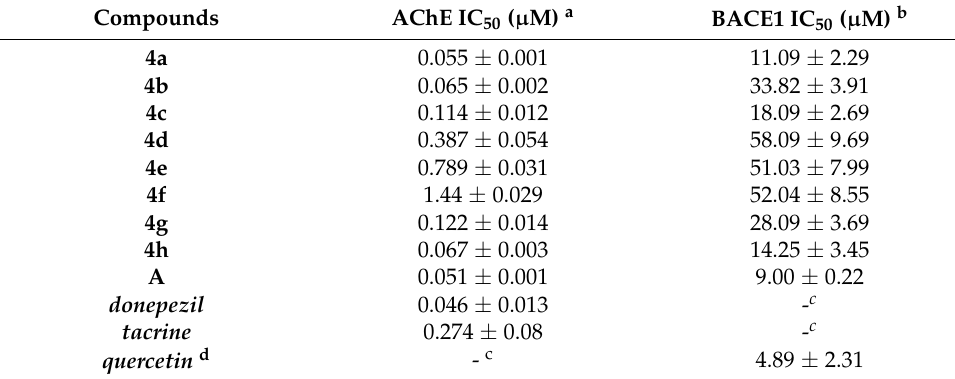
Table 2. In vitro inhibition of AChE and BACE1 of the target compounds.